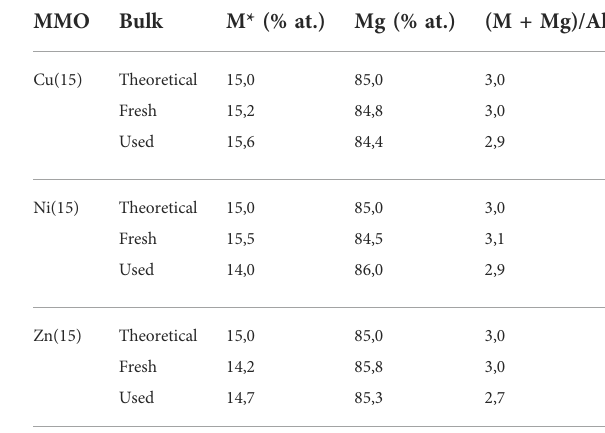
TABLE 4 Comparison of the metal composition in the bulk of the synthesis, fresh and used catalysts determined by MP-AES